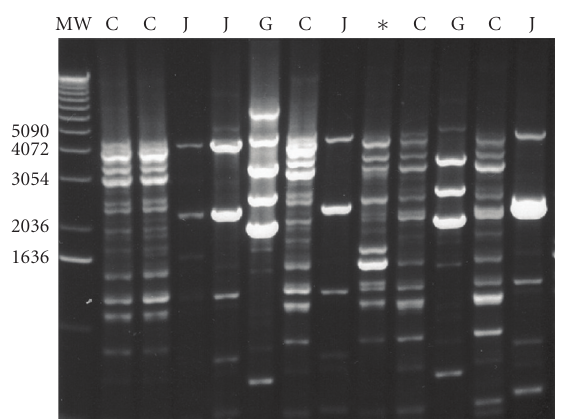
Figure 3: Representative rep-PCR DNA fingerprints from vaginal lactobacillus isolates. MW, Molecular weight standard; C, L. crispa- tus ; J, L. jensenii , G, L. gasseri ; ∗ , L. crispatus CTV-05.